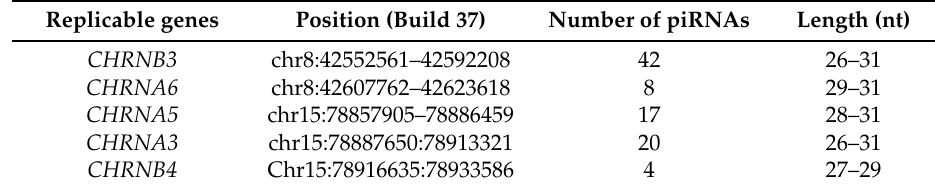
Table 7. The annotated piRNAs within the two replicable CHRN